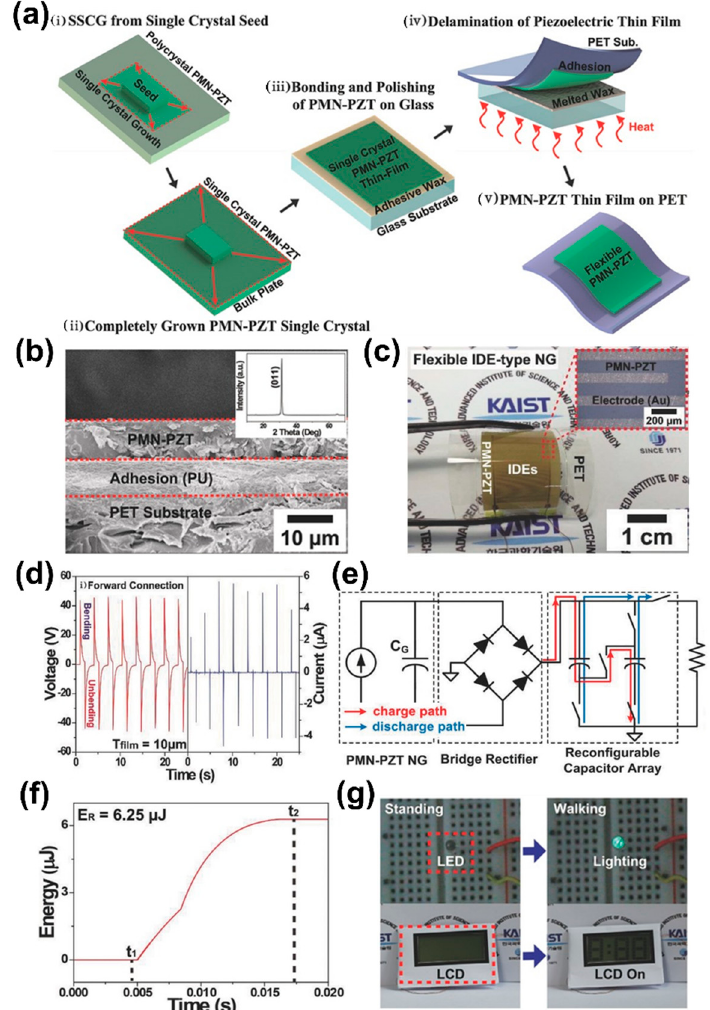
Figure 9. ( a ) Schematic diagram of the SSCG and fabrication method of a flexible PMN − PZT energy harvester. ( b ) Cross − sectional SEM image of PMN − PZT film on PET substrate. ( c ) Photograph of flexible PMN − PZT film energy harvesting device was bent by tweezers. ( d ) The generated voltage and current signals from the energy harvester during continual binding and unbending in forward connection. ( e ) Schematic circuit diagram of the designed reconfigurable rectifying circuit system composed of a flexible PMN − PZT energy harvester, bridge rectifier, external load resister and reconfigurable capacitor charger array. ( f ) The total converted heating energy from the reconfigurable rectifying system by one bending or unbending motion of the flexible PMN − PZT energy harvester. ( g ) The self − powered military boot powered a commercial LED and LCD with human walking. Reproduced with permission [28].